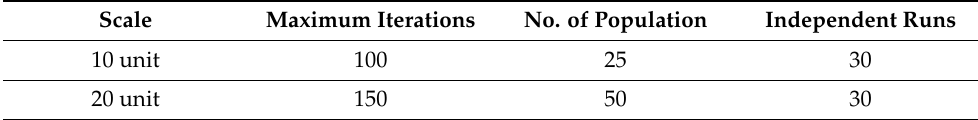
Table 4. Population size (test system 1).